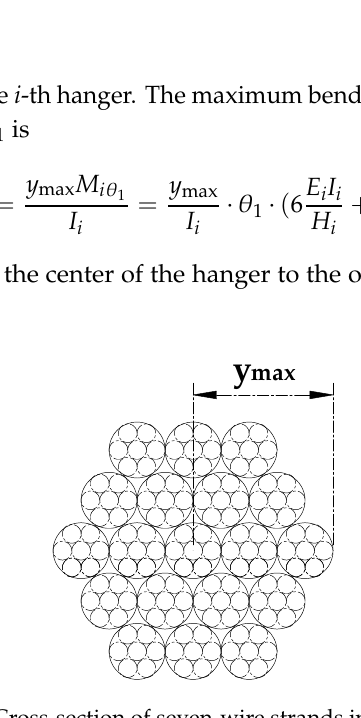
Figure 9. Cross-section of seven-wire strands in the hangers.